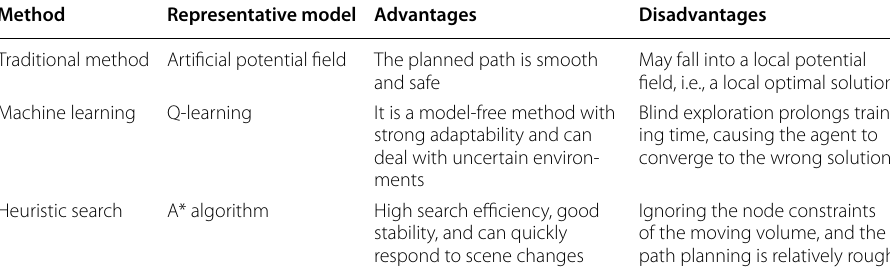
Table 1 Summary and comparison of three types of path planning